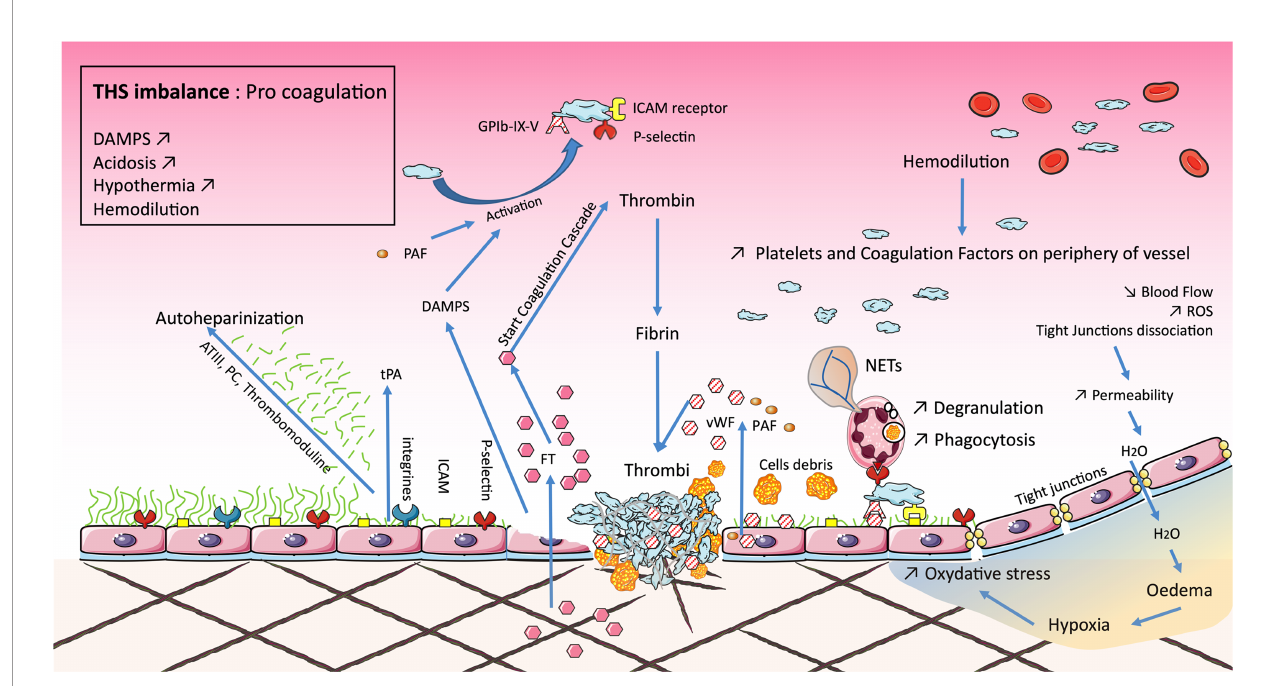
FIGURE 3 | Microvascular dysfunction occurring during traumatic hemorrhagic shock (THS) induces the permeability of tight junctions, responsible for edema, increased oxidative stress, and, ultimately, local in fl ammation. Endotheliopathy is either direct from tissue damage or secondary to microvascular dysfunction. Endothelial damage degrades the glycocalyx resulting in local autoheparinization. The shedding of the glycocalyx exposes integrins and selectins, promoting the adhesion of platelets and polynuclear neutrophils. Their association stimulates endothelial cells, which release factors such as sCD40L, von Willebrand factor (vWF), and platelet-activating factor (PAF). Endothelial damage is also associated with the release of damage-associated molecular patterns (DAMPs) and tissue factor (TF). This activates the coagulation cascade reducing the downstream blood fl ow, forming the bed of coagulopathy in 15% of cases, the latter leading to disseminated intravascular coagulopathy (DIC). These phenomena are associated with the lethal triad: coagulopathy, acidosis, and